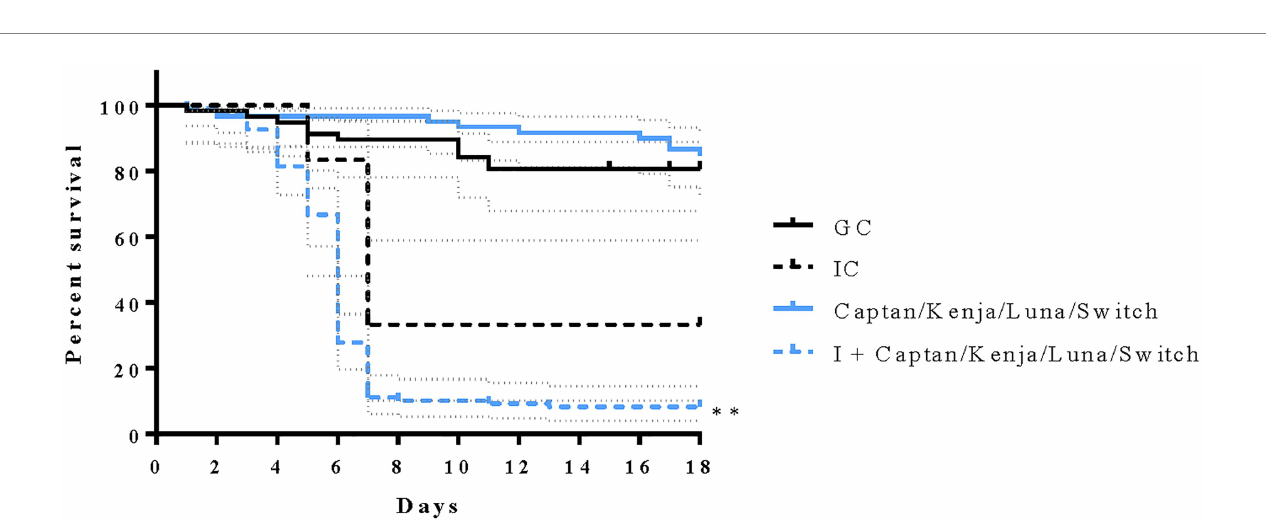
FIGURE 5 Effects of chronic exposure to four fungicidal products on larval survival from European foulbrood disease in vitro. Solid and dashed lines represent the percent survival ± confidence interval (dotted grey lines) of honey bees until adult emergence for 58 grafting control larvae (GC; solid black line), 60 larvae chronically exposed to four fungicides simultaneously (solid blue line), 12 infected control larvae (IC; dashed black line) inoculated with 50 colony forming units (CFU) of M. plutonius 2019 BC1, and 108 larvae that were infected (I) with 50 CFU of M. plutonius and subsequently administered fungicidal product in the diet (dashed blue line). Fungicide-exposed larvae received low concentrations of Captan, Kenja, Luna, and Switch. ** p < 0.01 by a Mantel–Cox log rank